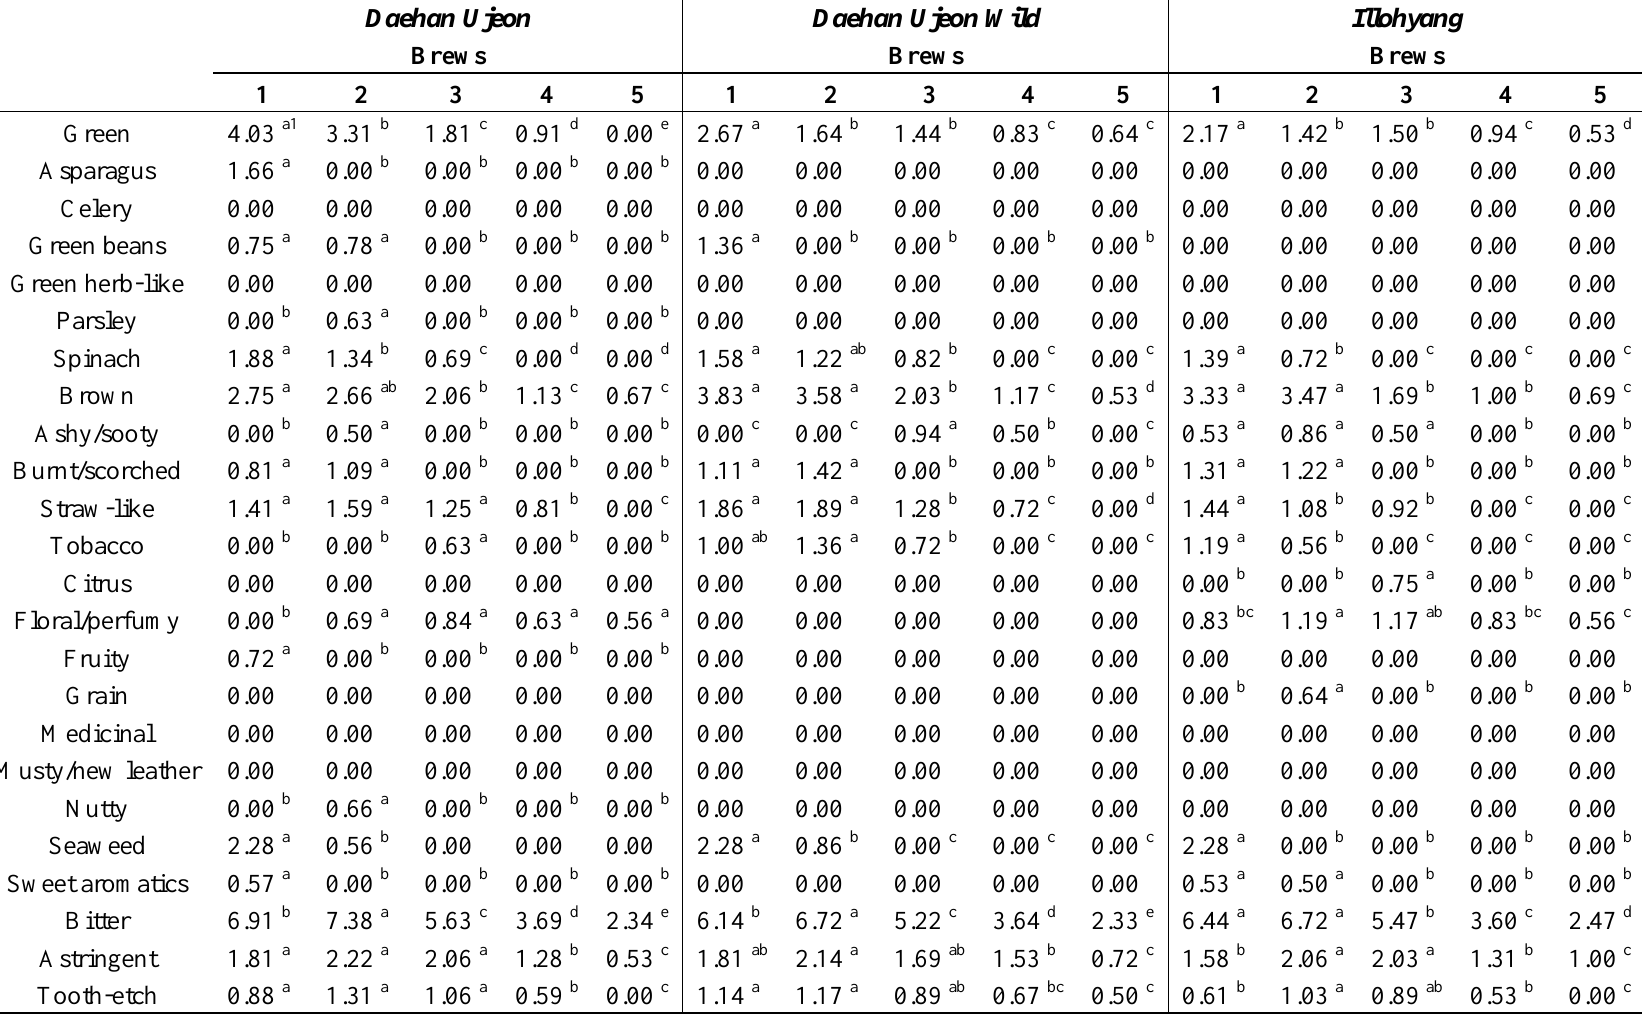
Table 2. Mean scores and significant differences in flavor attributes for green tea brewed five times. Daehan